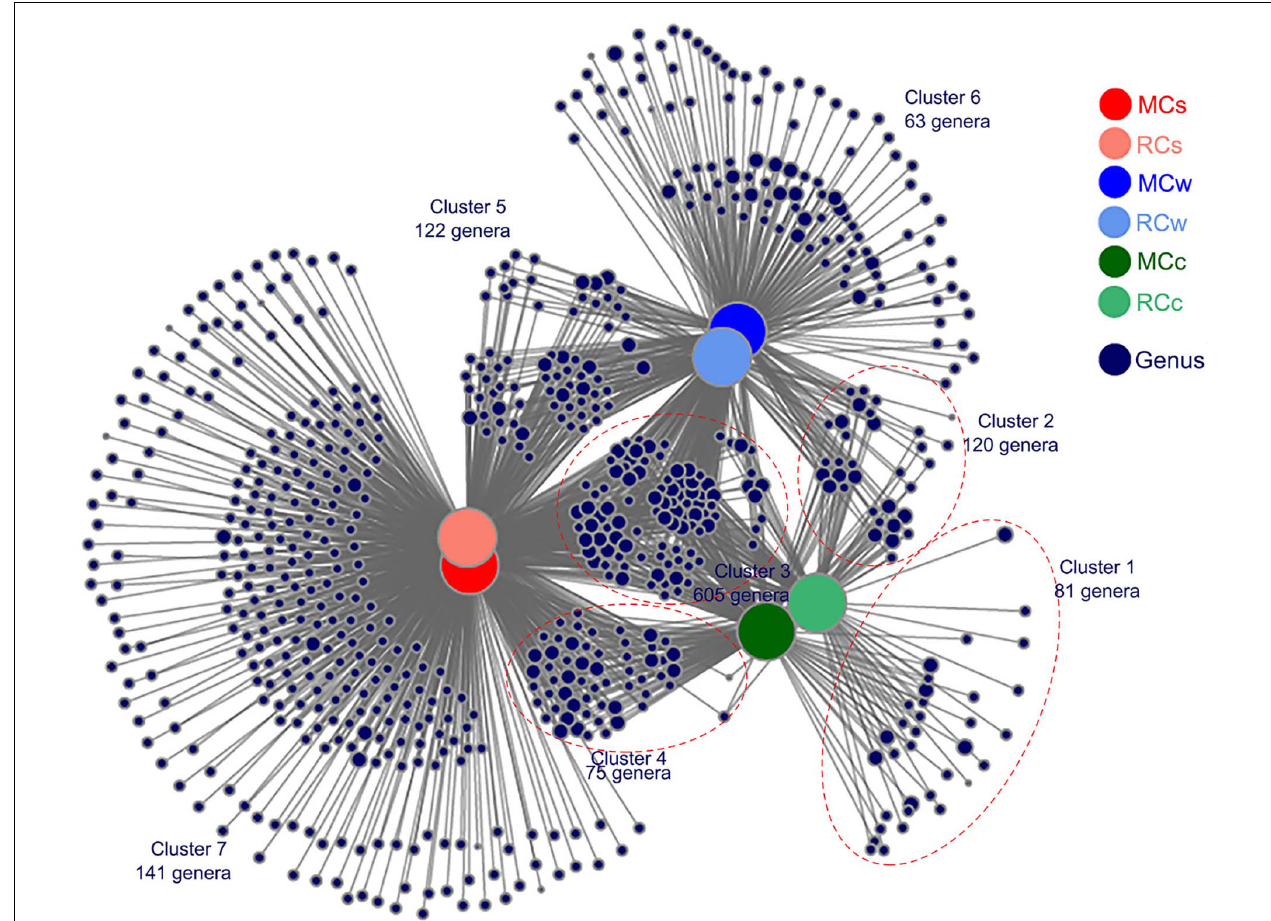
FIGURE 5 | Bipartite co-occurrence network showing the associations between genera and the different samples. Genera with ≥ 5 sequence numbers were reserved. Node sizes represent the relative abundance of the genera in the data sets, with bigger nodes indicating greater abundances. Edges represent the association patterns of individual genus with the sampling